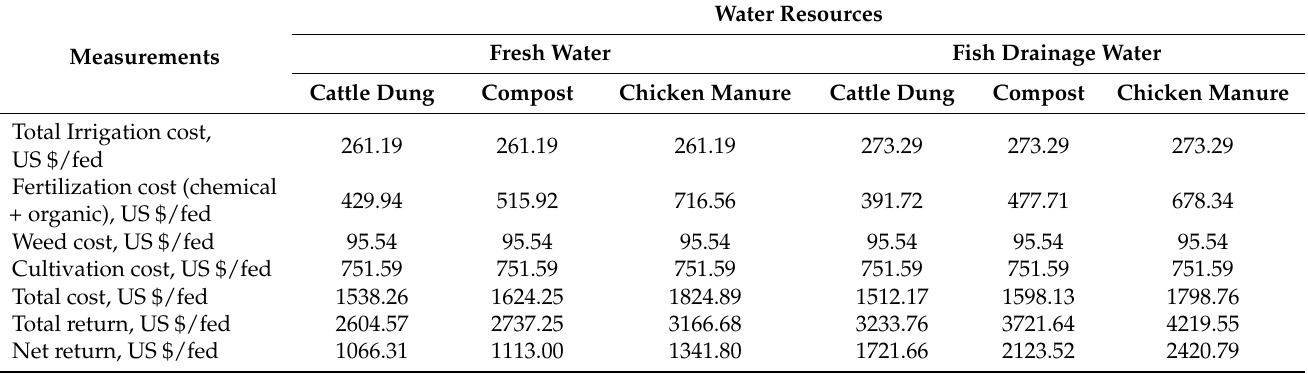
Table 7. Total cost, return and net return of pomegranate trees under different water resource and fertilizer